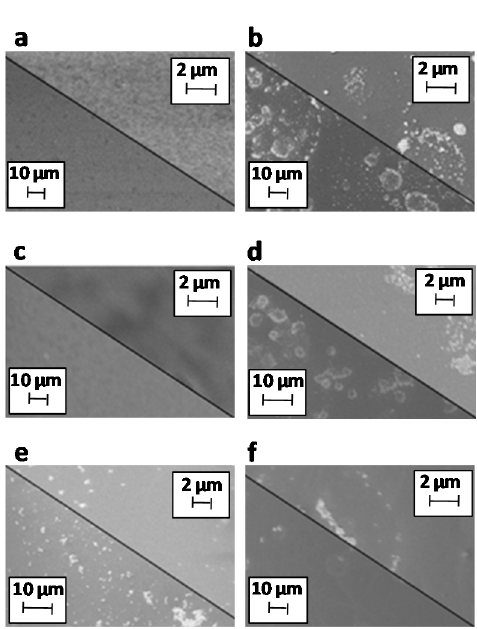
Figure 4. Scanning electron microscope (SEM) images of ZnONPs films obtained by gravure printing ( a ) and airbrushing ( b ), and ZnONPs / stearic acid coatings GP2 ( c ), AB2 ( d ), GP1 ( e ) and AB1 ( f